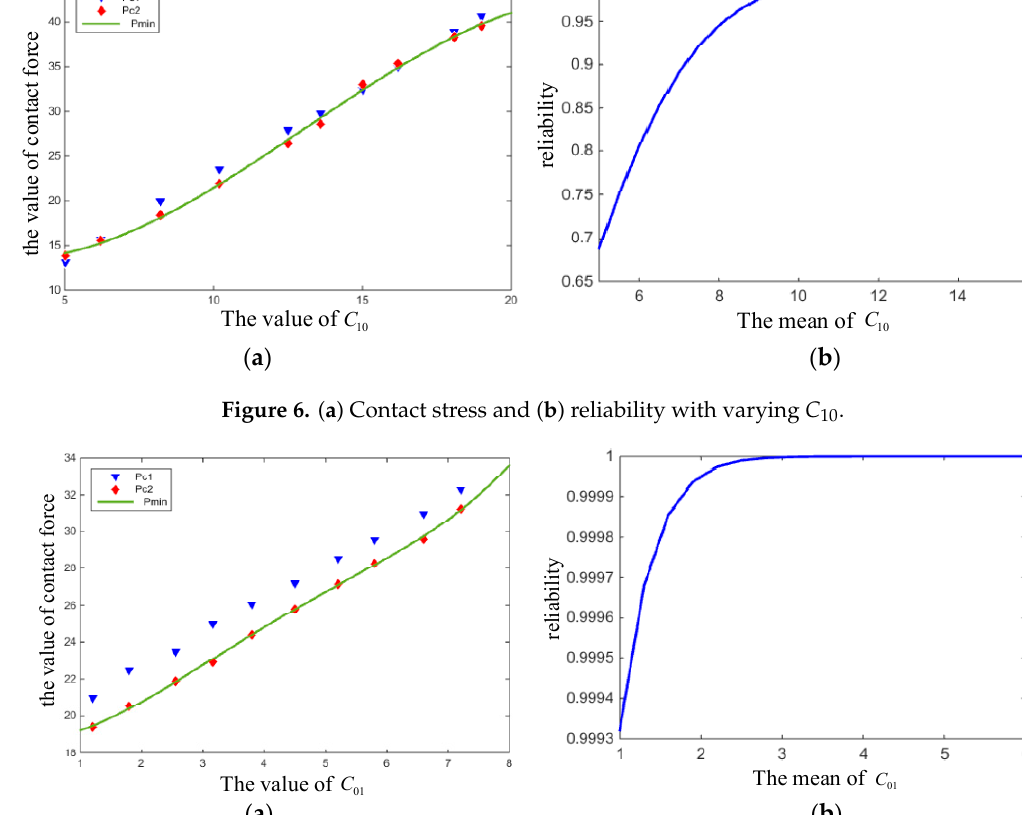
Figure 7. ( a ) Contact stress and ( b ) reliability with varying C 01 .